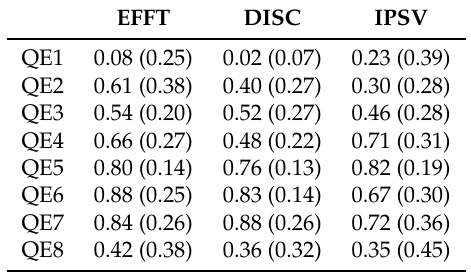
Table 3. SAVRa mean and deviation values in terms of VLT session. The display format was x ( y ) , where x was the mean and y was the standard deviation. QE i (i = 1...8): quality evaluation. EFFT: